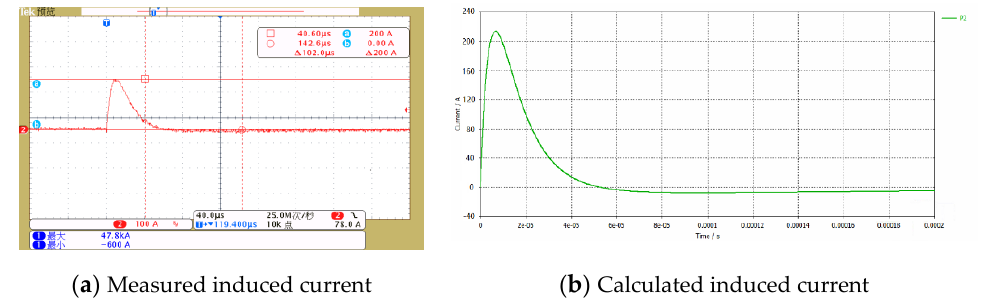
Figure6. Comparison between the measured and calculated induced current. Figure 6. Comparison between the measured and calculated induced current.